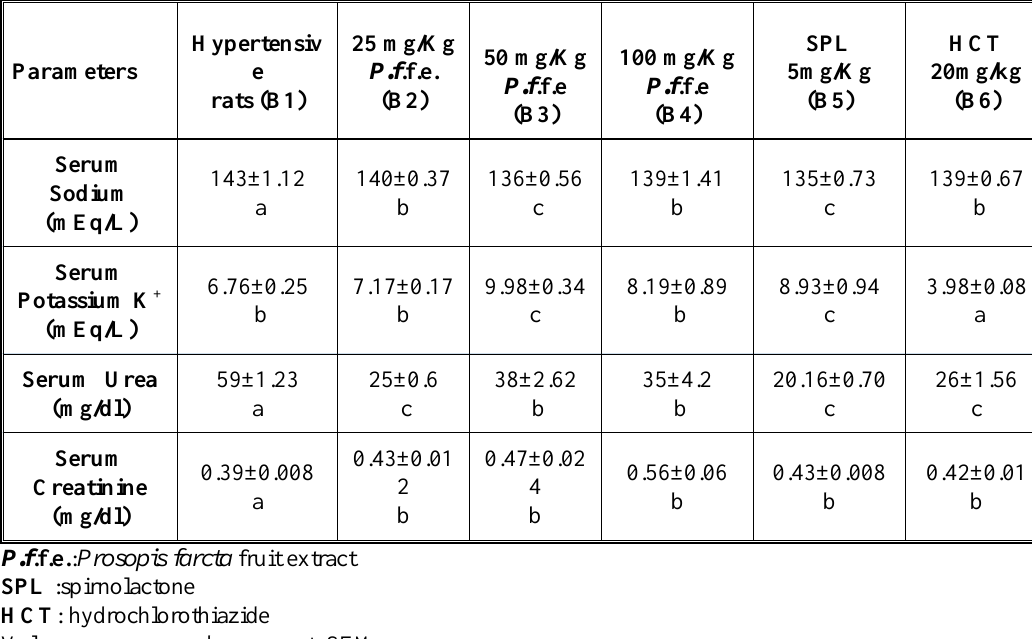
Table 7. Effects of different doses of P. farcta fruit extract, spironolactone (5mg/kg) and hydrochlorothiazide(20mg/kg) on serum electrolytes, serum urea and creatinine concentration in hypertensive rats(